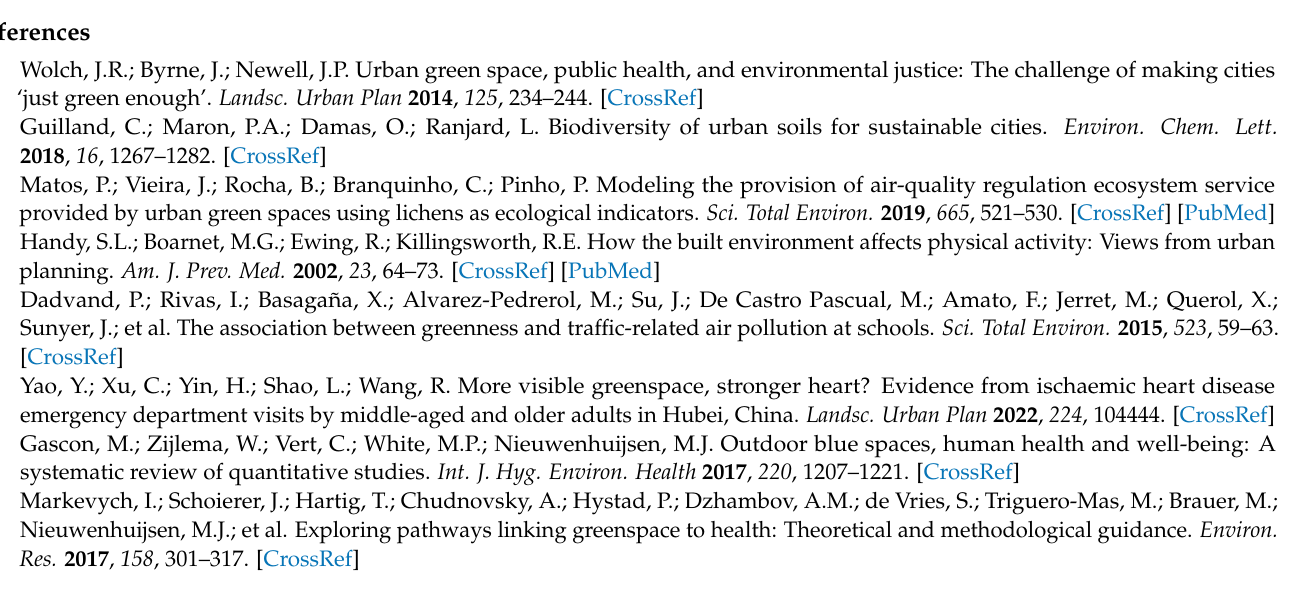
Figure A1. Validation result of the FGVR (lateral view).